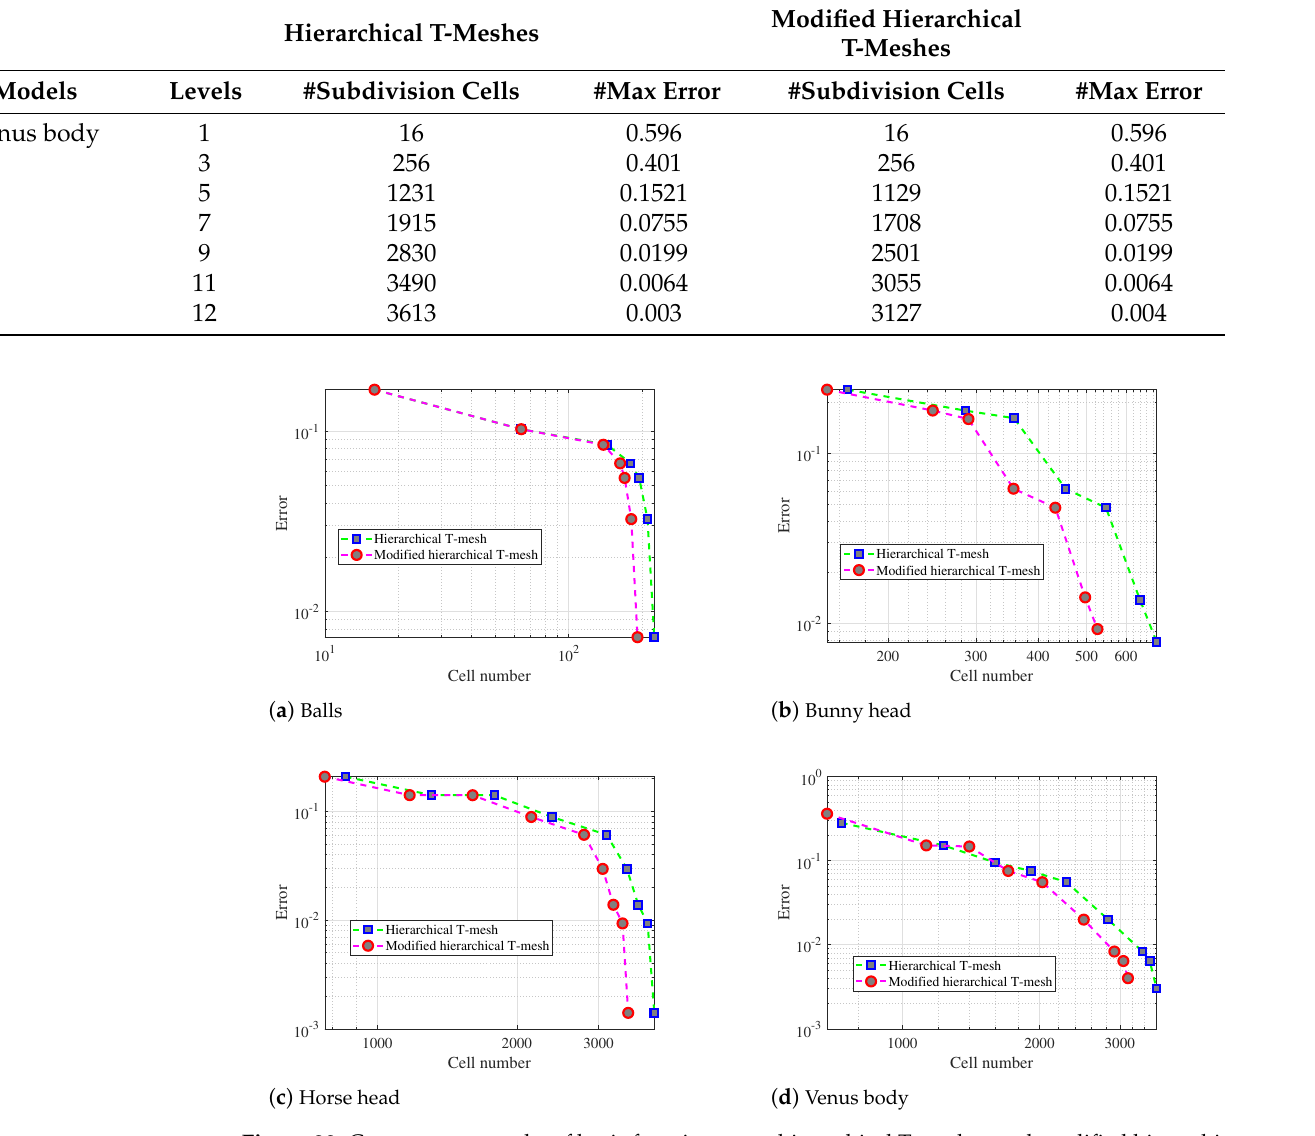
Figure 20. Convergence results of basis functions over hierarchical T-meshes and modified hierarchi- cal